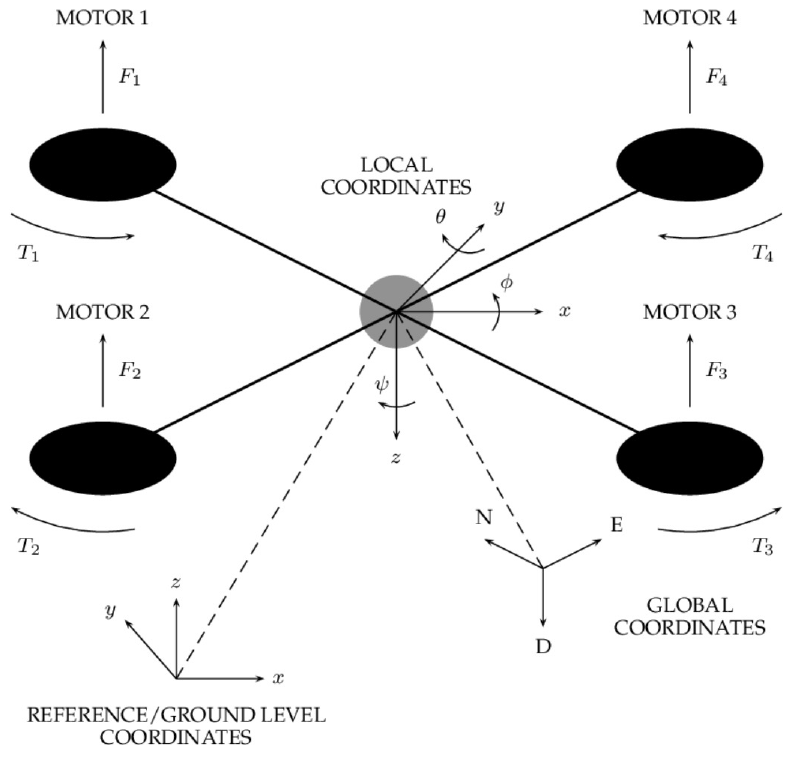
Figure 1. Coordinate systems and Euler